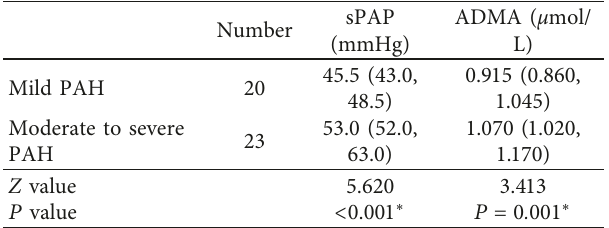
Figure 1: Comparison of serum ADMA levels among three groups. Serum ADMA levels were measured in CTD-without PAH group, CTD-with PAH group, and healthy control group. Data were expressed as mean ± SD. ∗ P < 0 . 001 compared with the CTD-with PAH group. Table 3: ADMA of CTD patients with different degrees of